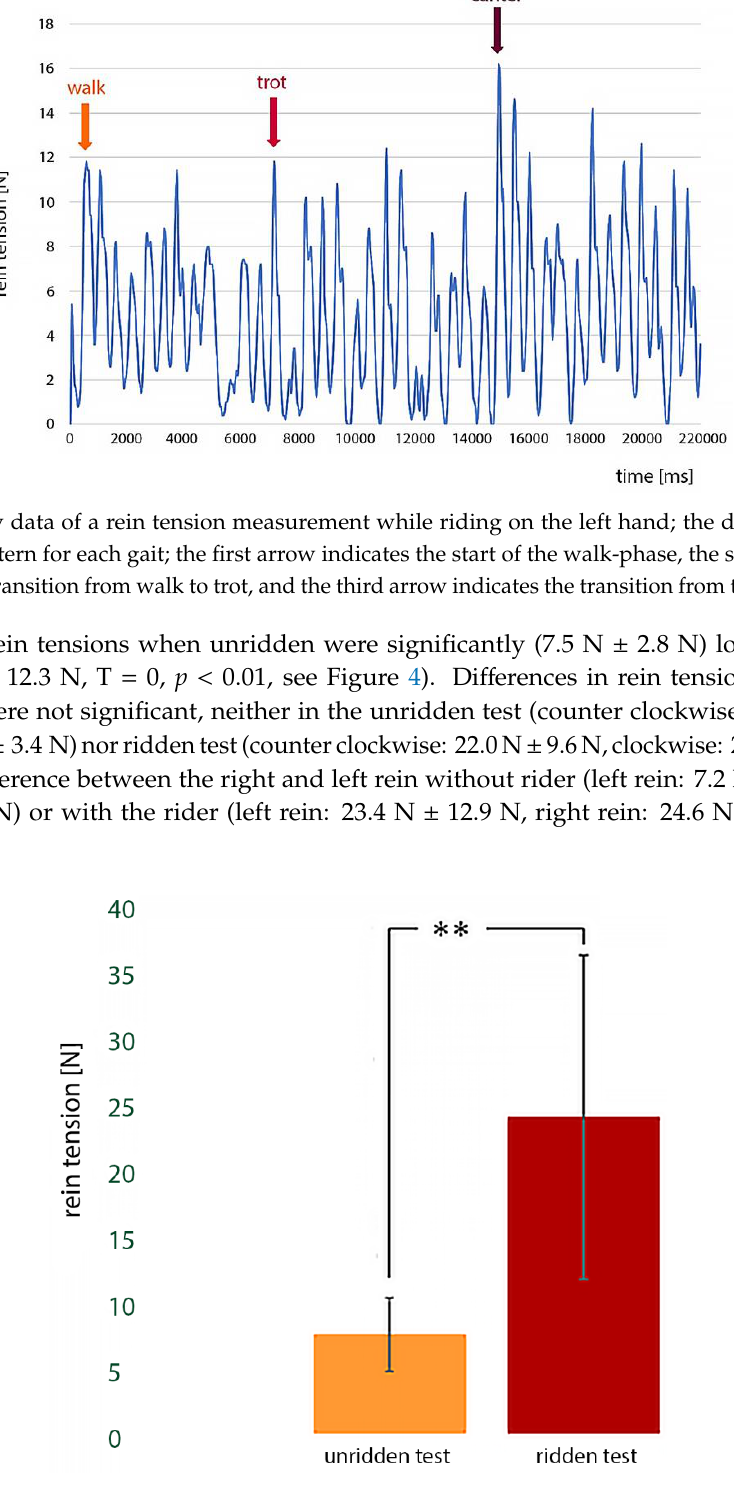
Figure 4. Mean values of the maximum peaks of rein tension in the unridden and ridden tests; the rein tension in the ridden test (24.0 N ± 12.3 N) is significantly ( p < 0.01) higher than the rein tension in the unridden test (7.5 N ± 2.8 N); ** indicates p <